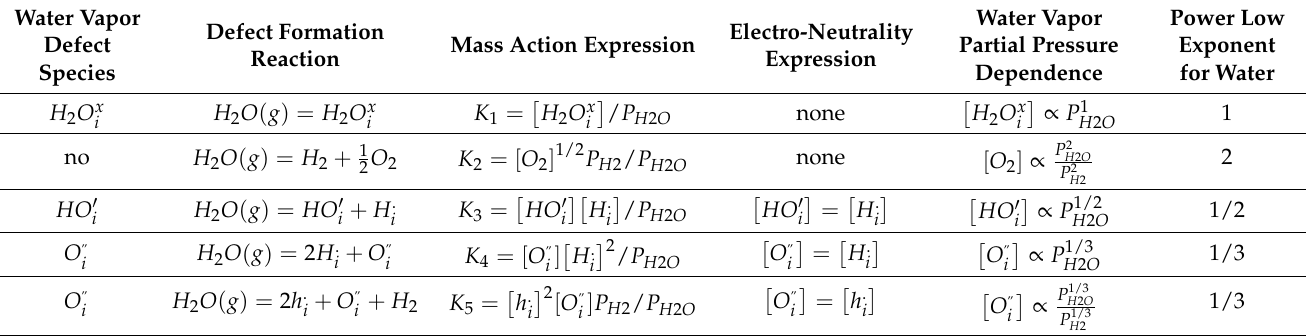
Table 5. Water partial pressure dependence for several water vapor defect species using standard Kroger–Vink notation (from Reference